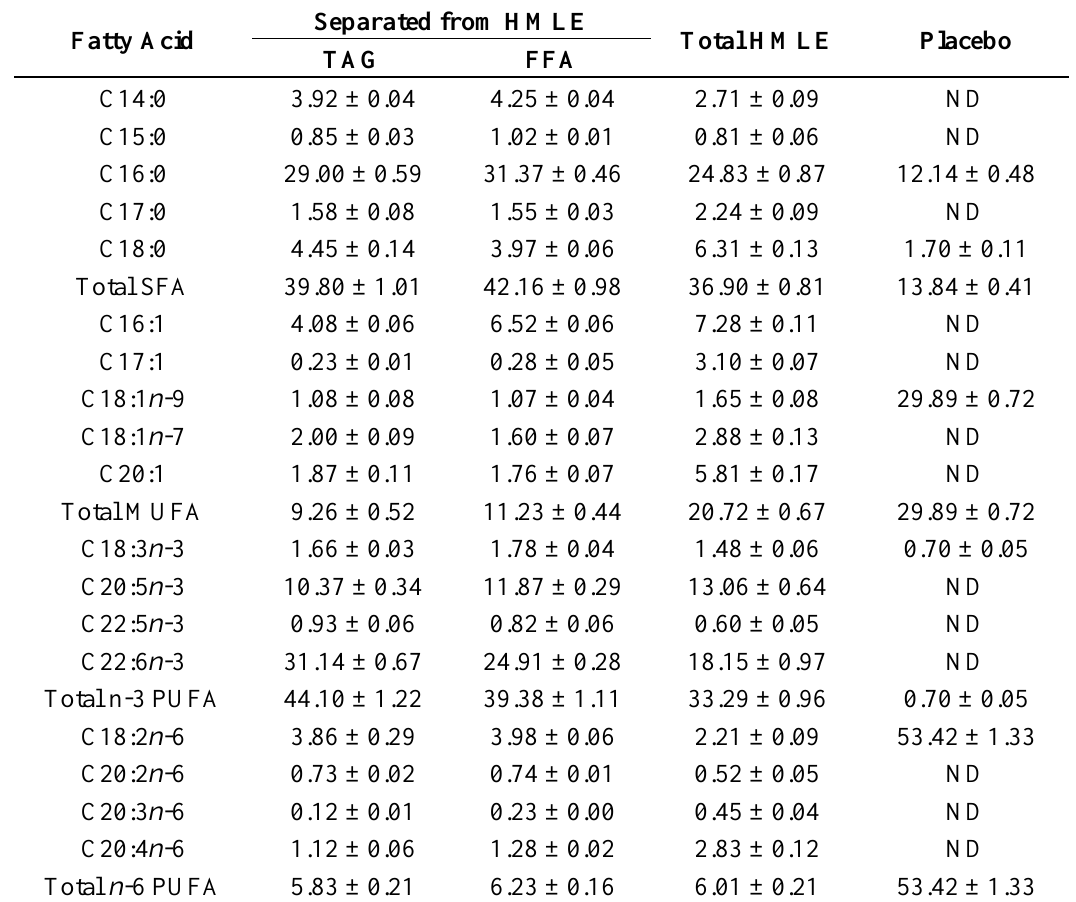
Table 1. Fatty acids composition (% of total fatty acids) of HMLE and placebo. Separated from HMLE Fatty Acid